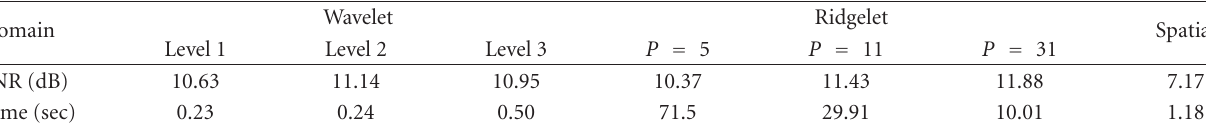
Table 1: Wavelet and ridgelet comparisons depending on SNR and processing